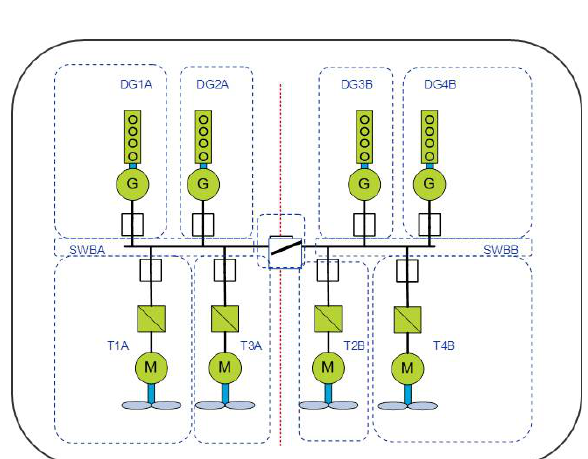
Figure 12: A DP vessel is arranged with 4 trusters and 4 diesel-generators. The A -side (port) and B -side (starboard) consist of switch- board SWBA and switchboard SWBB , each with 2 connected diesel-generators and 2 thrusters, respectively. The switchboards SWBA and SWBB are connected with a bus-tie breaker X , labeled subsystem C